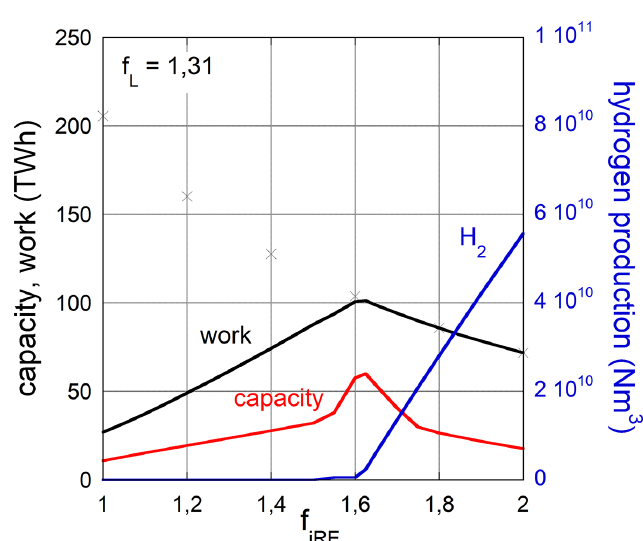
Fig. 9. – For f L = 1 . 31, corresponding to the consumption of 650 TWh as expected for Germany for 2030 [18], storage capacity, storage work and possible hydrogen generation are plotted versus the normalised intermittent iRE share f iRE . The symbols ( × ) represent backup energy in case of no